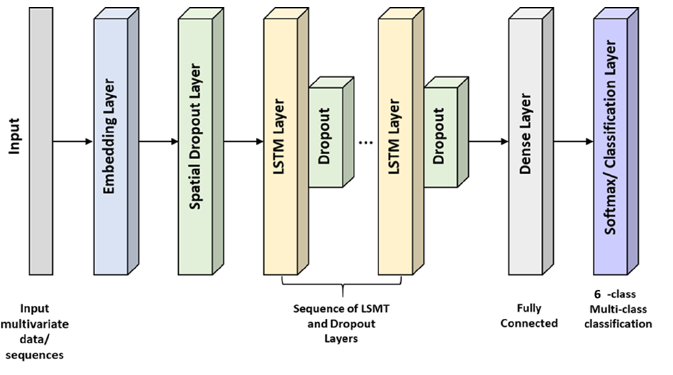
Figure 2. High-level architecture of the proposed multi-class LSTM scheme on the Suricata pf- Sense